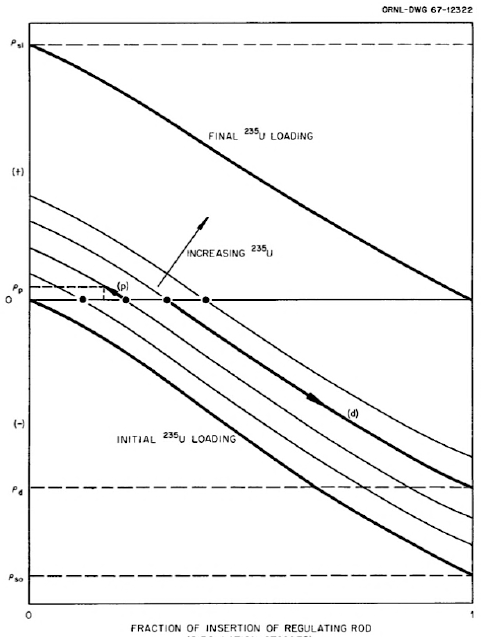
Figure 4. Graphical Description of Control Rod Calibration Experiments